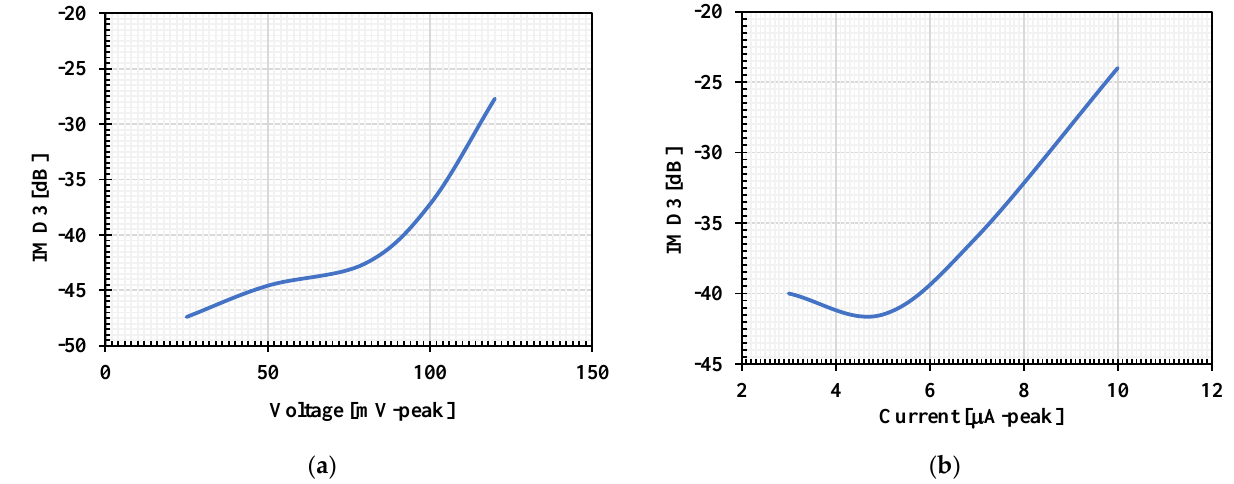
Figure 13. The simulated IMD3 versus the input signal for the BP filters: ( a ) voltage (V in -peak); ( b ) voltage (I in -peak).